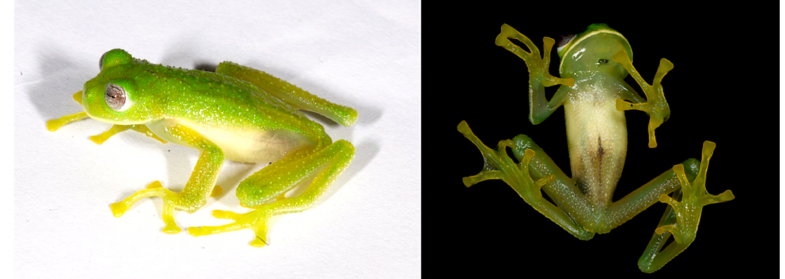
Figure 148. Nymphargus garciae in life from Ecuador, Napo province, trail from Oyacachi to El Chaco, 3012 m, MZUTI 764. Photos by Eduardo